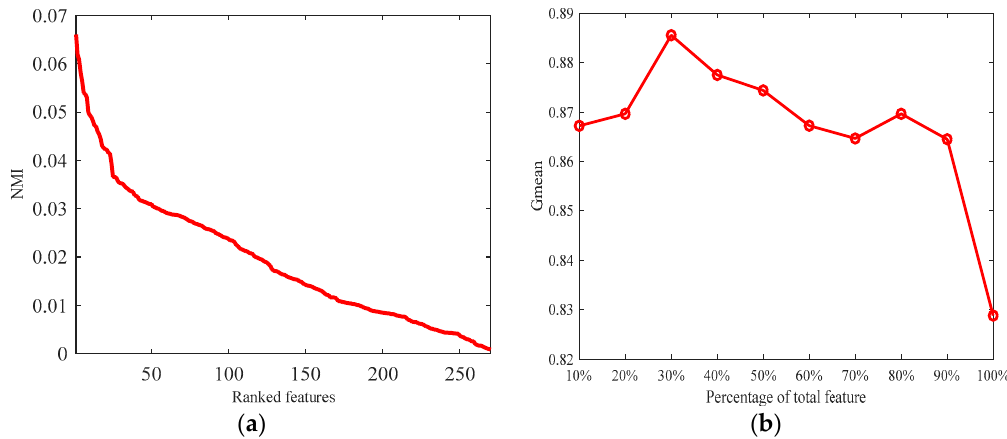
Figure 5. Feature selection results in the first stage: ( a ) Ranked features results; ( b ) Performances with different percentages of total feature.